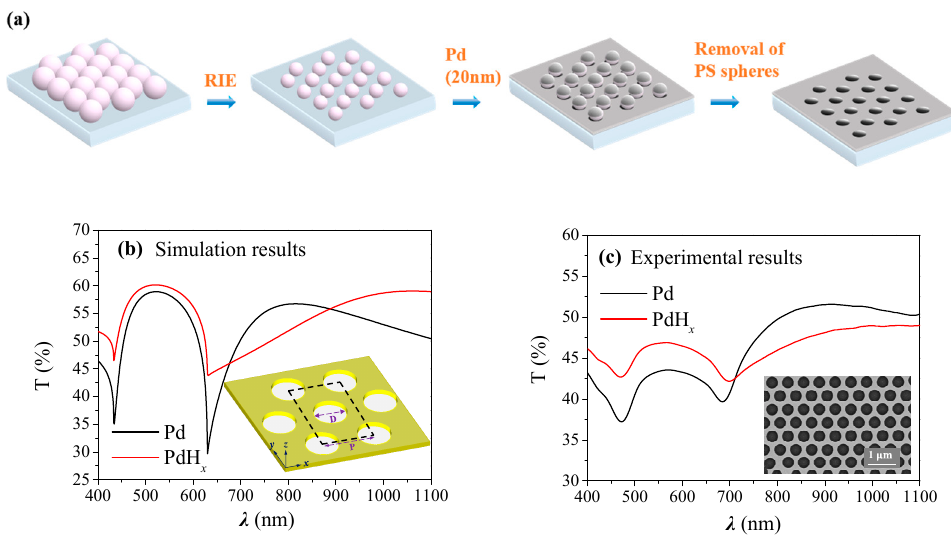
Figure 1. Fabrication and optical characterization of Pd NHA. ( a ) Schematic of the fabrication process of Pd NHA; ( b ) Simulated transmission spectra of Pd NHA ( D = 360 nm, P = 500 nm) before (black) and after (red) H 2 adsorption. The inset shows the geometrical configuration of Pd NHA and the unit cell for numerical simulations; ( c ) Experimentally measured transmission spectra of the Pd NHA ( P = 500 nm, D = 360 nm) before (black) and after (red) H 2 adsorption. The inset shows the SEM image of the nanohole arrays. D and P represent the diameter of the nanohole and the period of the array,